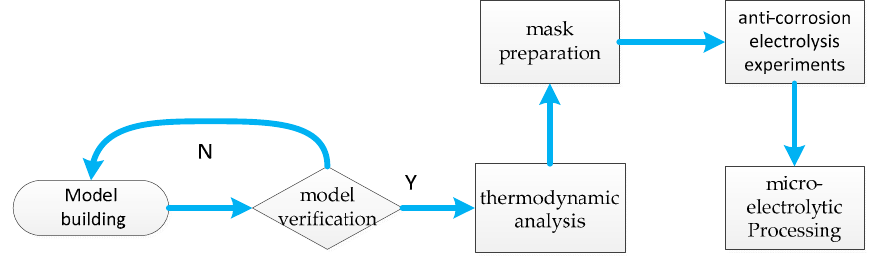
Figure 1. Flowchart of the research work.